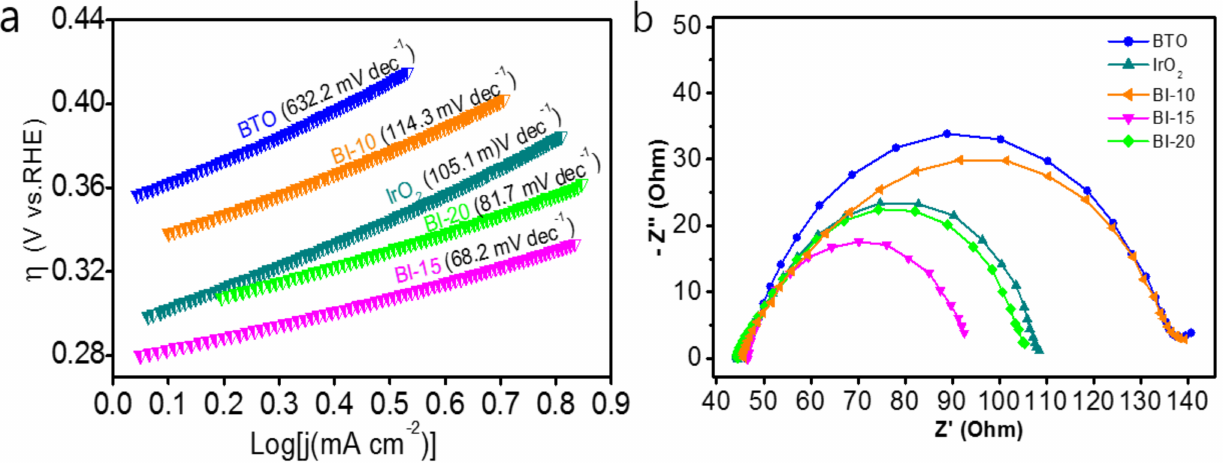
Figure 4. ( a ) Tafel slopes of BTO, IrO 2 , BI − 10, BI − 15, and BI − 20 electrodes. ( b ) Electrochemical impedance spectrogram of BTO, IrO 2 , BI − 10, BI − 15, and BI − 20 electrodes at the potential of 1.27 V, conducted before OER